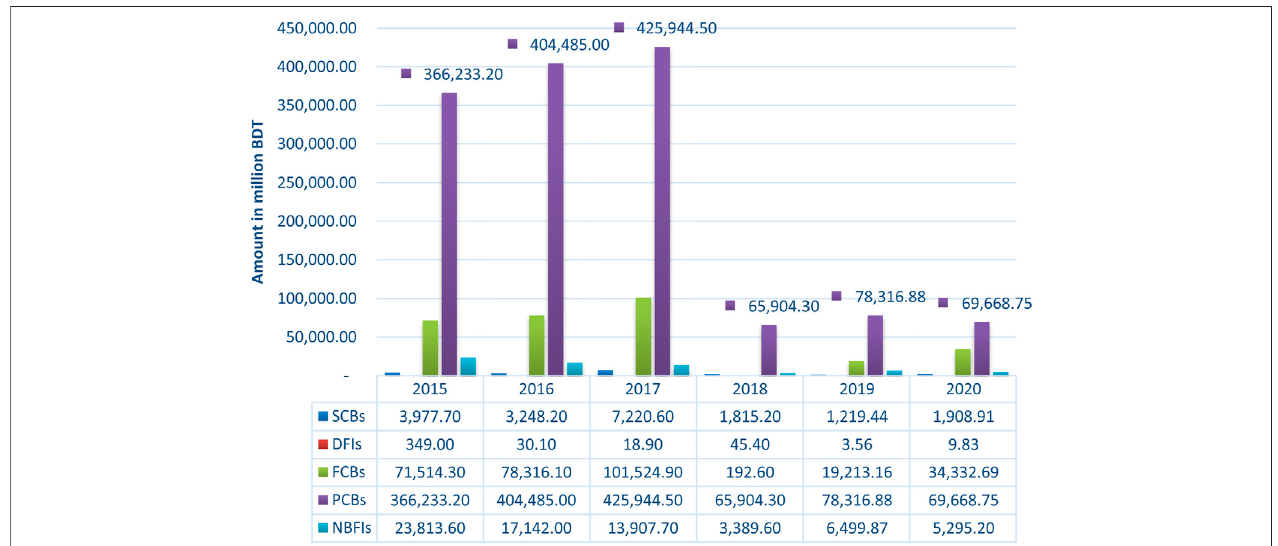
FIGURE 2 | Green fi nancing by banks and non-banks fi nancial institutions in Bangladesh during the period 2015 – 2020.